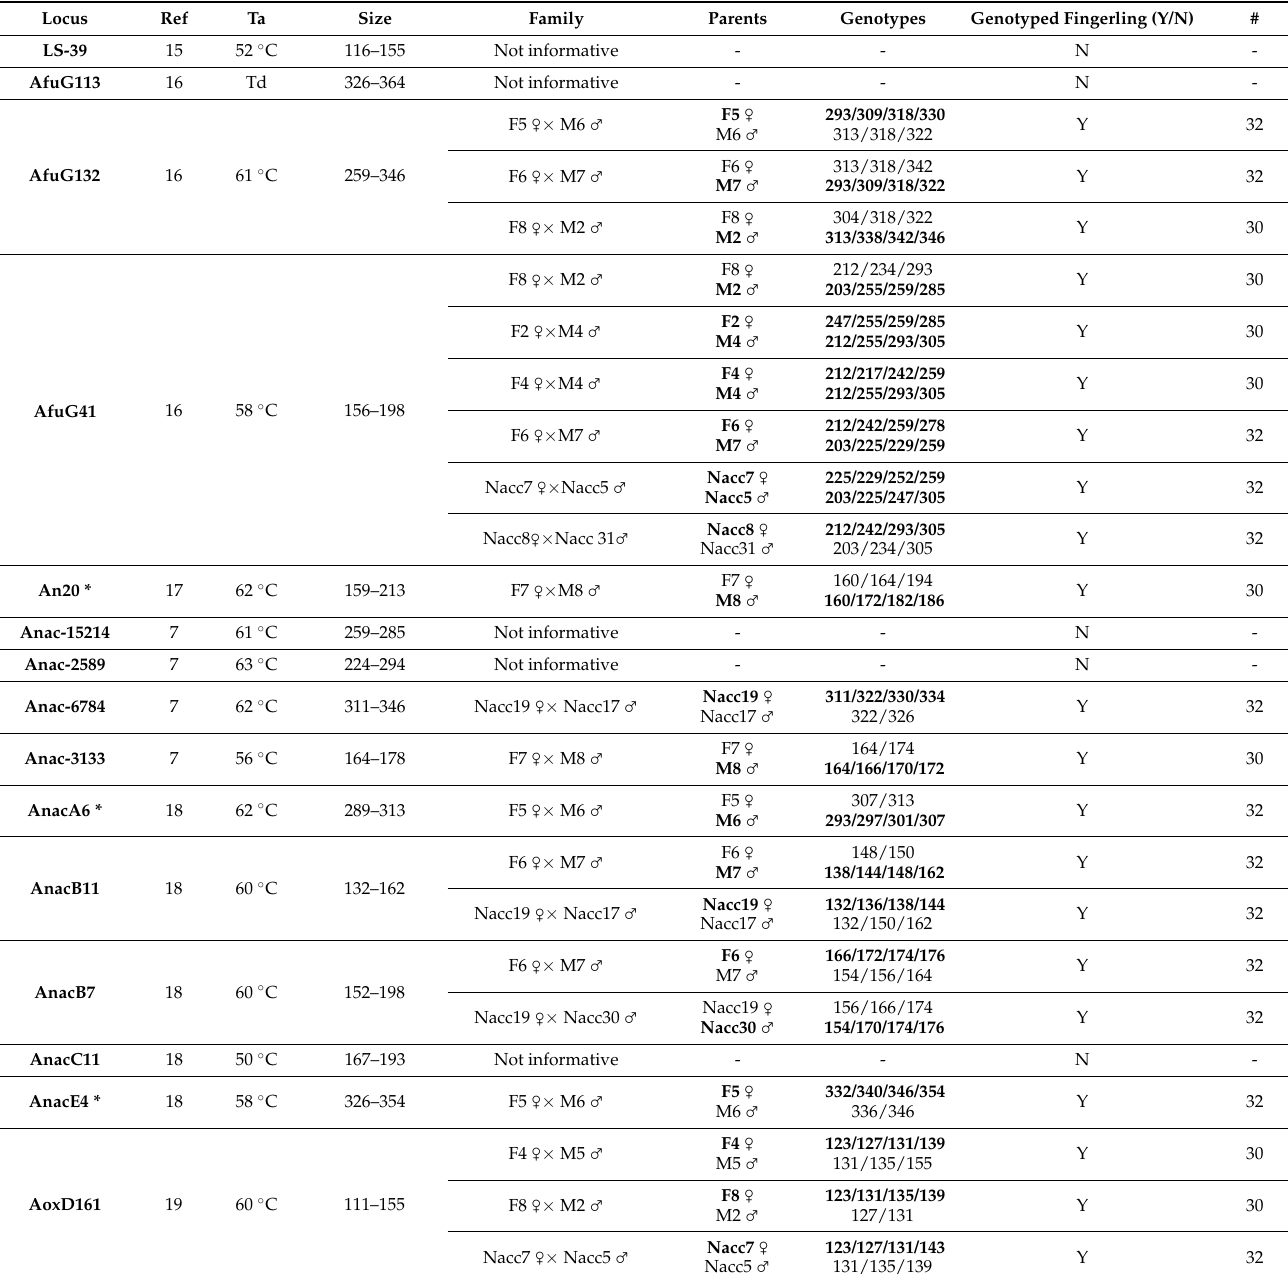
Table 1. Screening of microsatellite